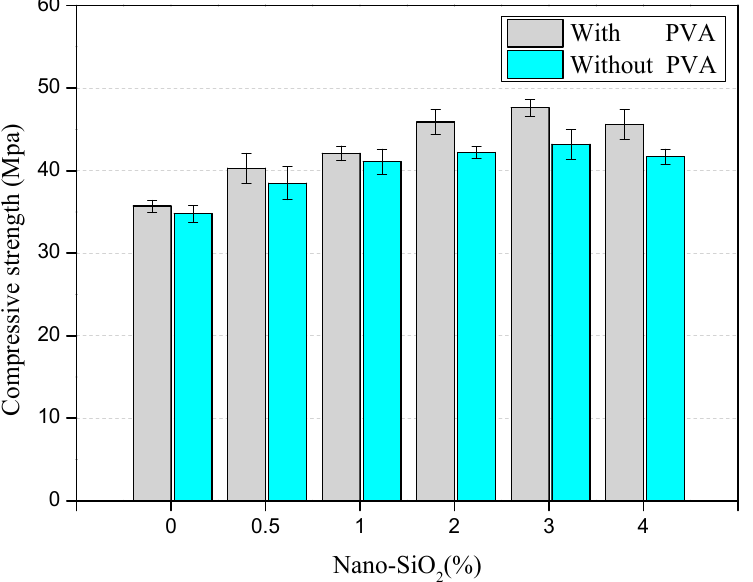
Figure 4. Compressive strength of nano-SiO 2 (NS)-recycled aggregate concrete with and without PVA fibers.